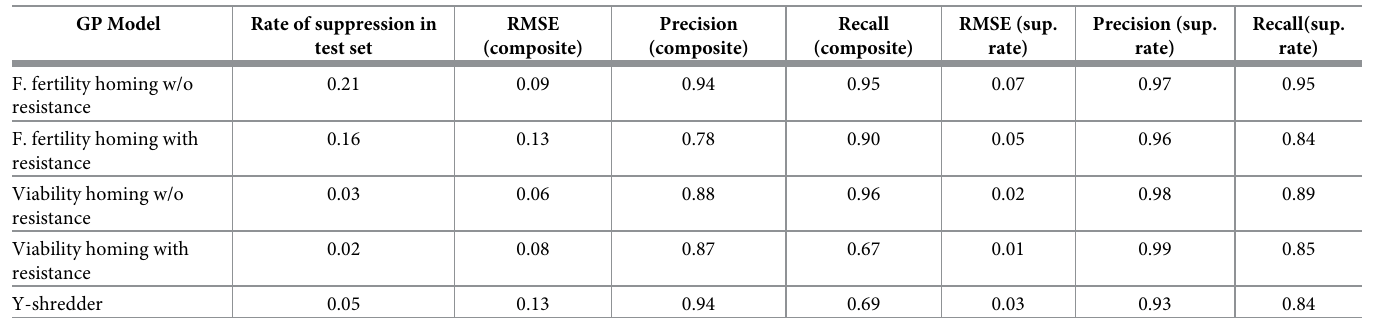
Table 3. Gaussian Process Model